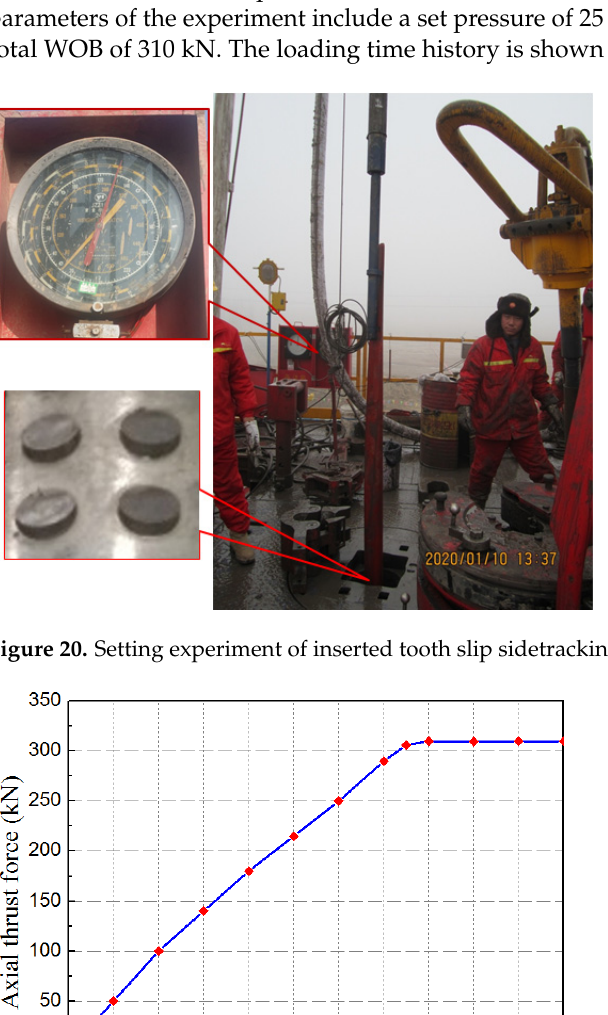
Figure 19. The strain distribution of casing wall (after optimization).